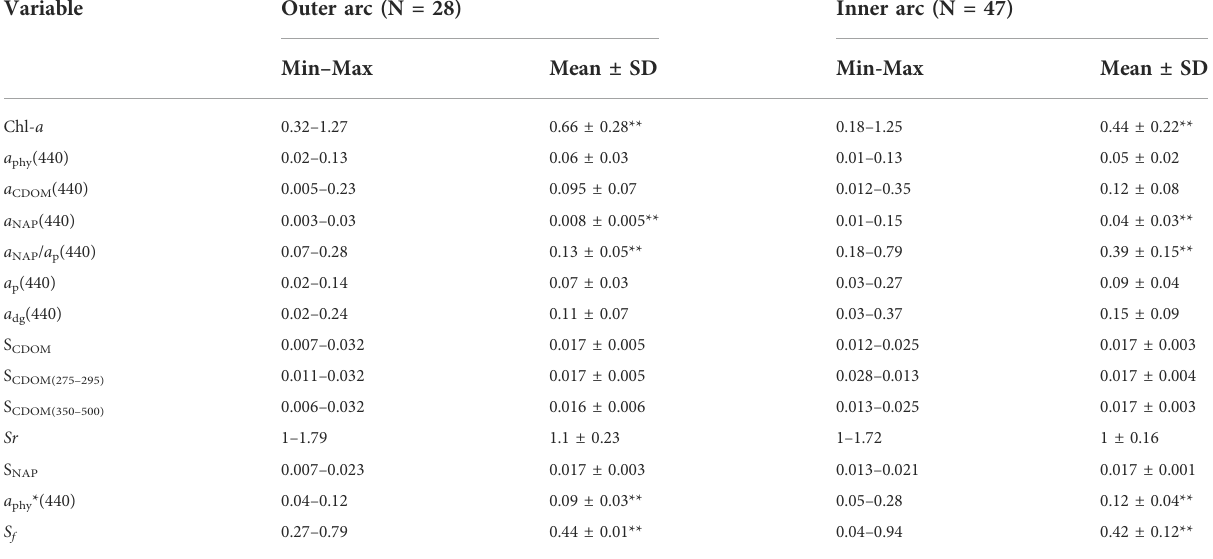
TABLE 3Range (MeanandStandardDeviation)ofthe measuredopticalproperties intheouterandthe innerarcs forthe Abrolhos Bank region during the 2013 and 2016 fi eld campaigns. See Table 1 for acronyms.